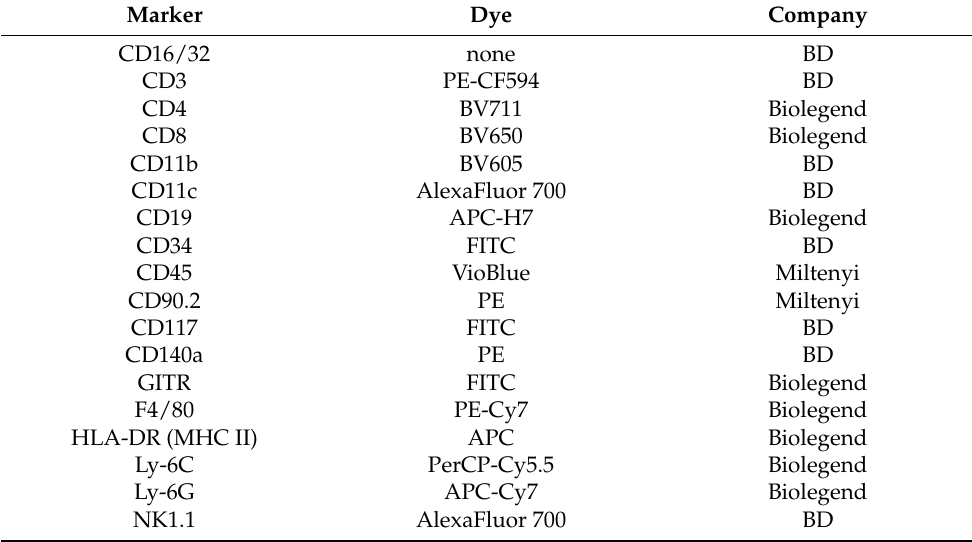
Table 1. To analyze immune cells in the peritoneum the following antibodies were used. Marker Dye